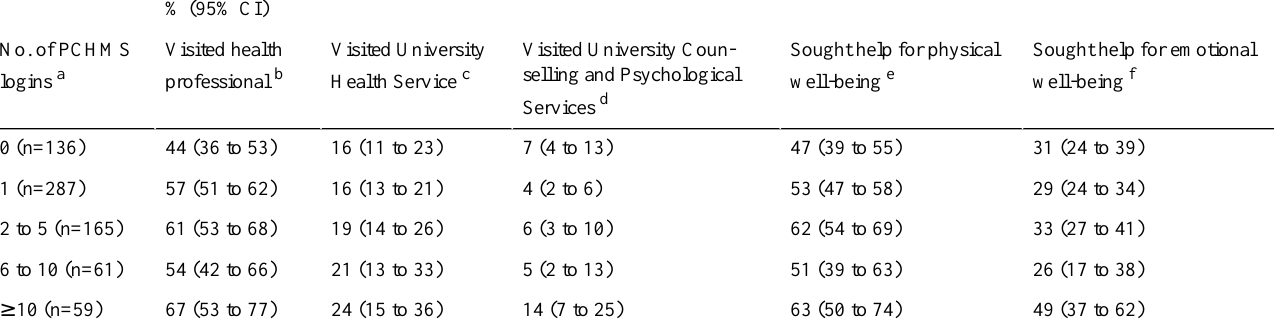
Table 3. Health service utilization and help-seeking behaviors according to different usage levels of PCHMS.